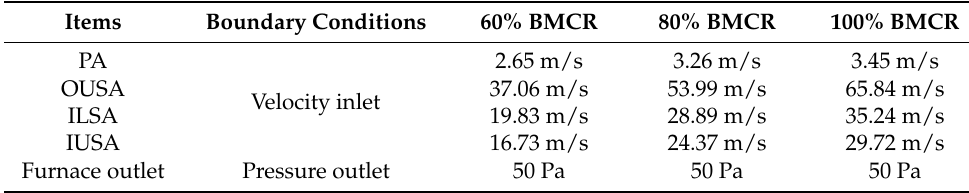
Table 3. Boundary conditions and parameter setting at the uniform SA